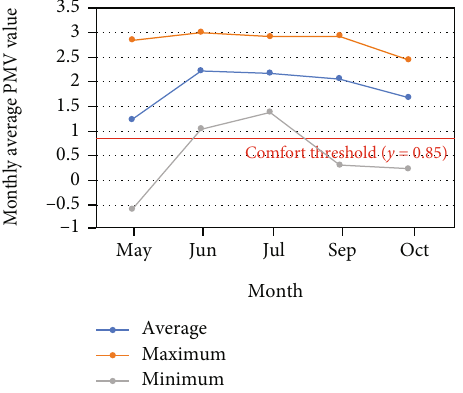
Figure 12: Monthly average PMV.